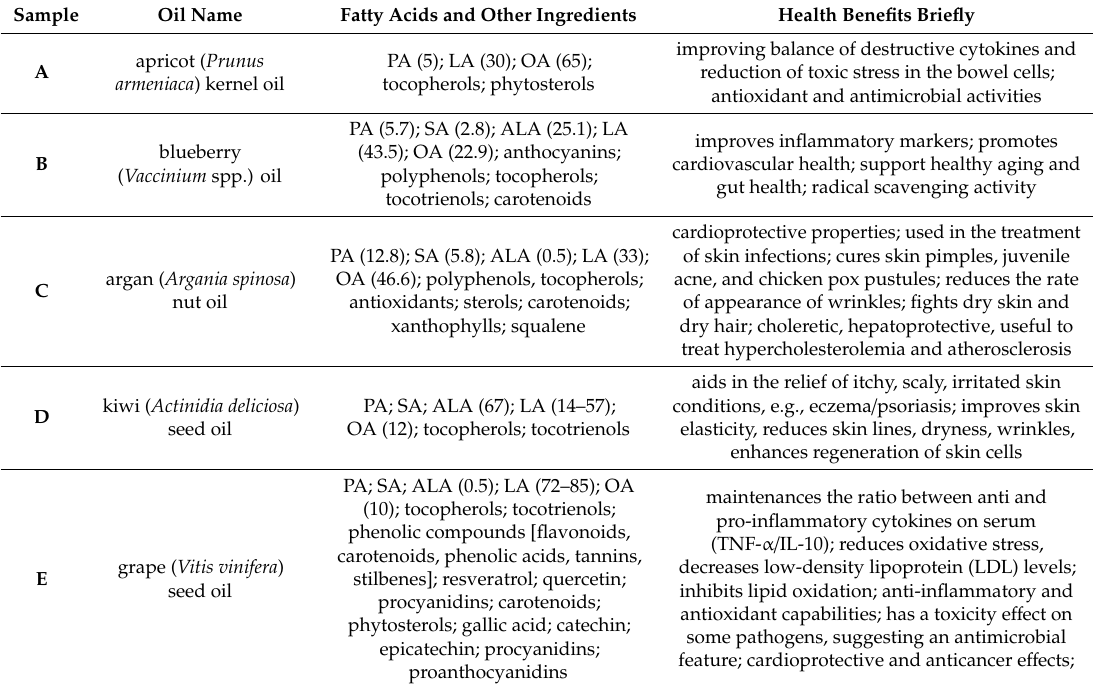
Table 3. The composition profile of studied oils (based on the references: